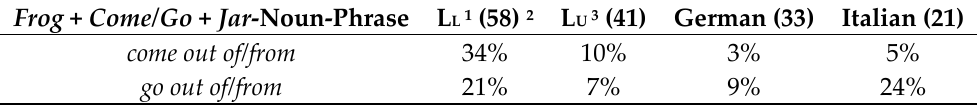
Table 7. Deictic perspective ( come vs. go ) in the frog-leaves-jar scene.